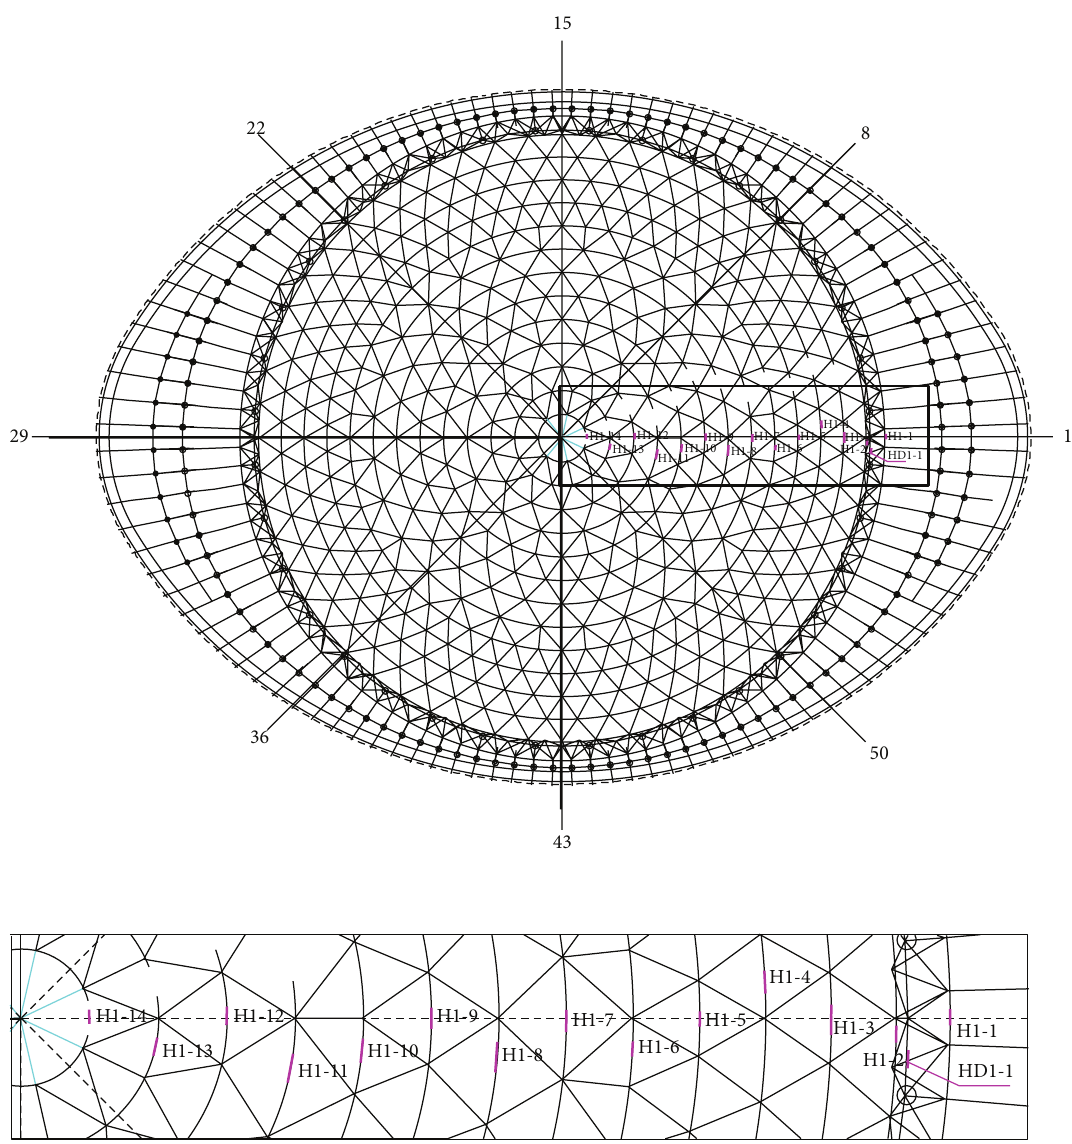
Figure 6: Layout of hoop